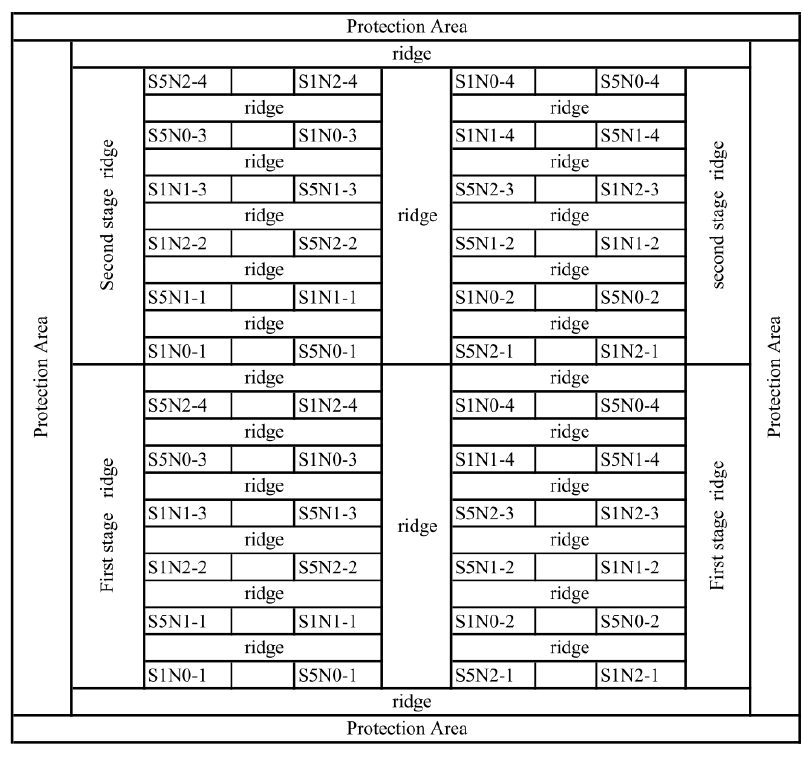
Figure 2. Field plot configuration of the paddy rice experiment for different nitrogen levels, species and transplanting dates in 2004. S1, S2, S3, S4, and S5 represent Xiushui 110, Jiayu 293, Jiazao 312, Z00324, and Xieyou 9308, respectively. N0, N1, and N2